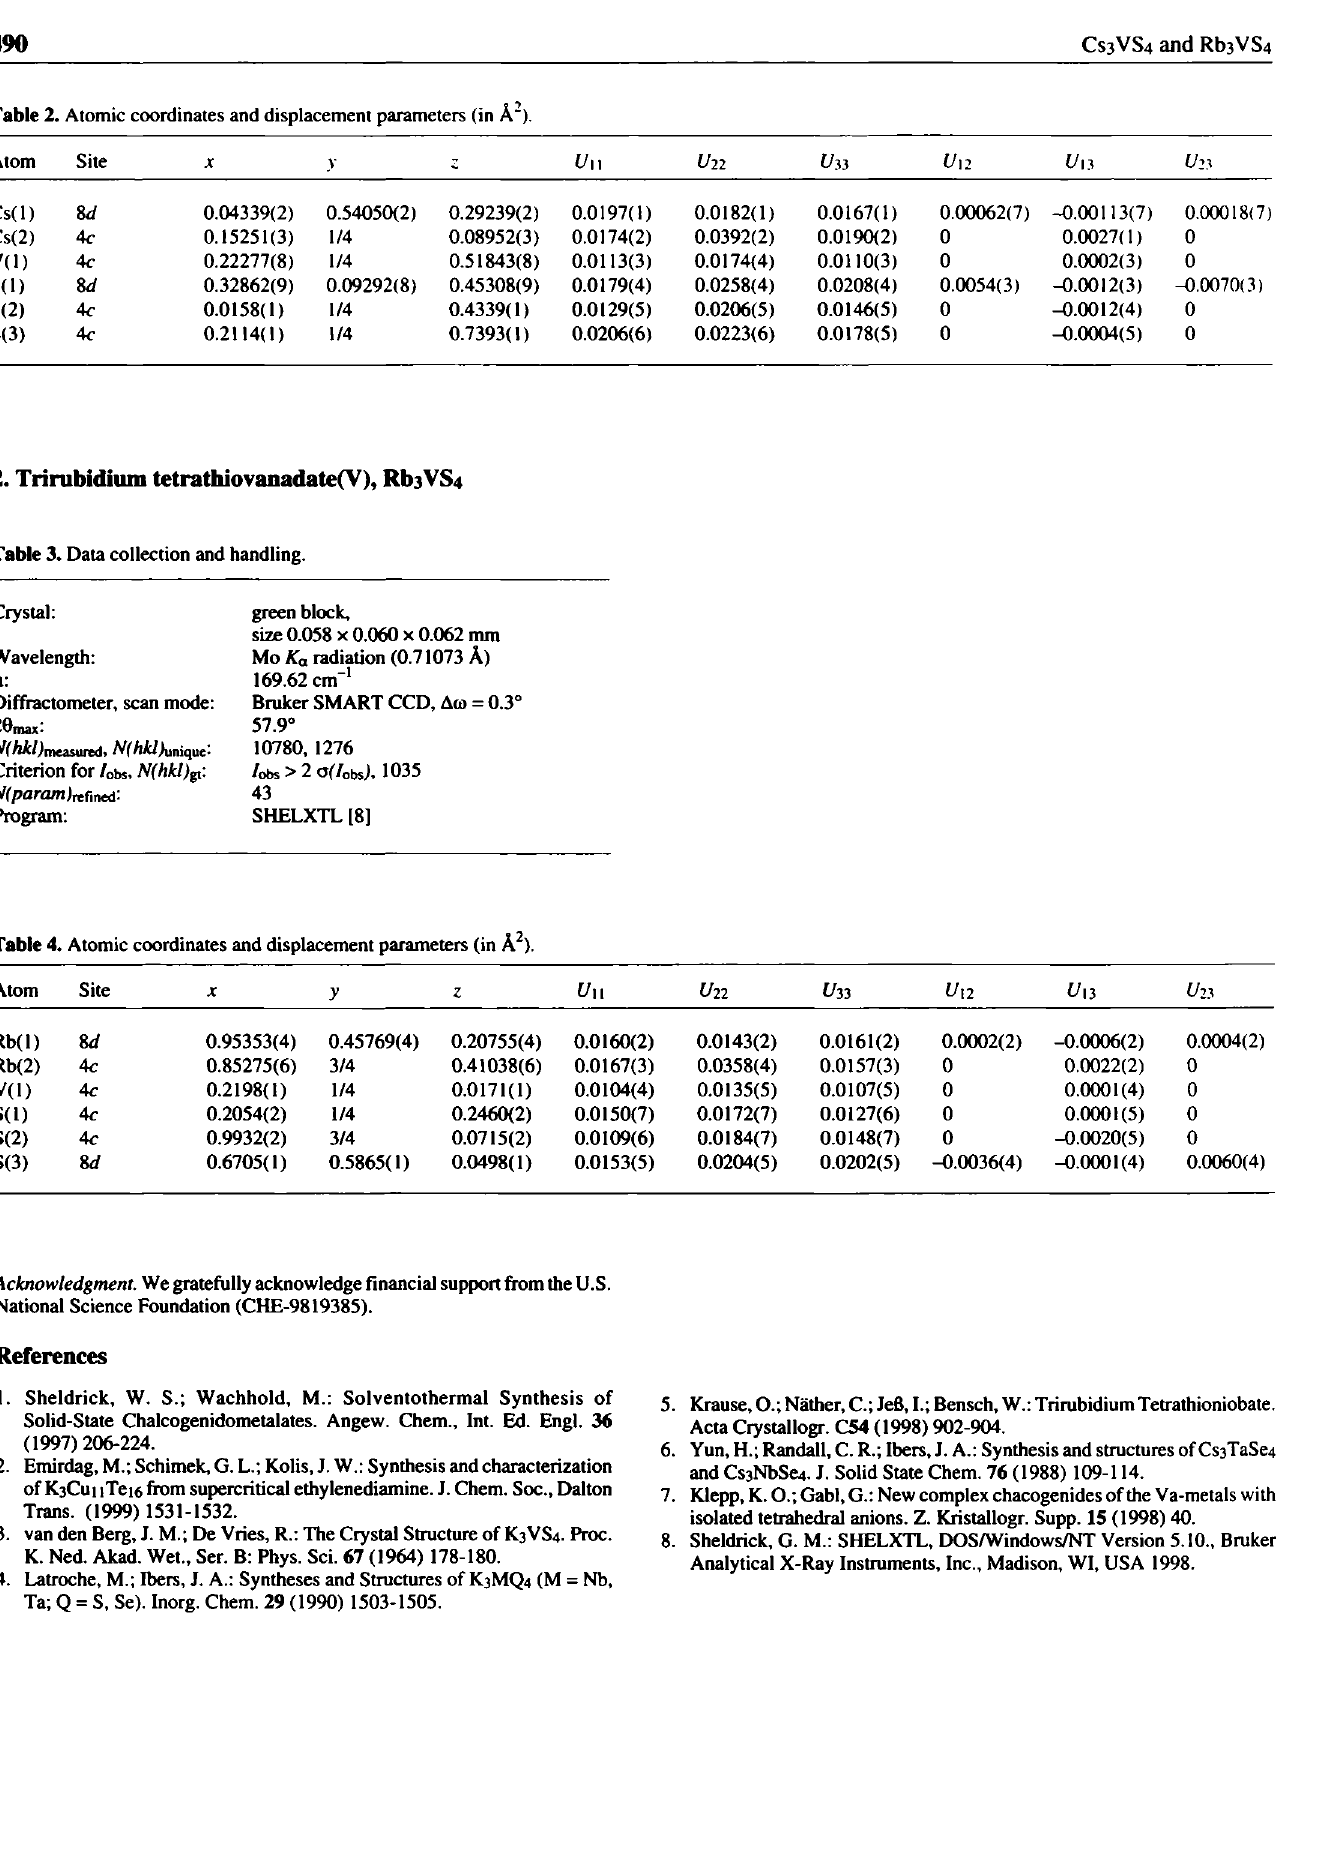
Table 3. Data collection and handling.